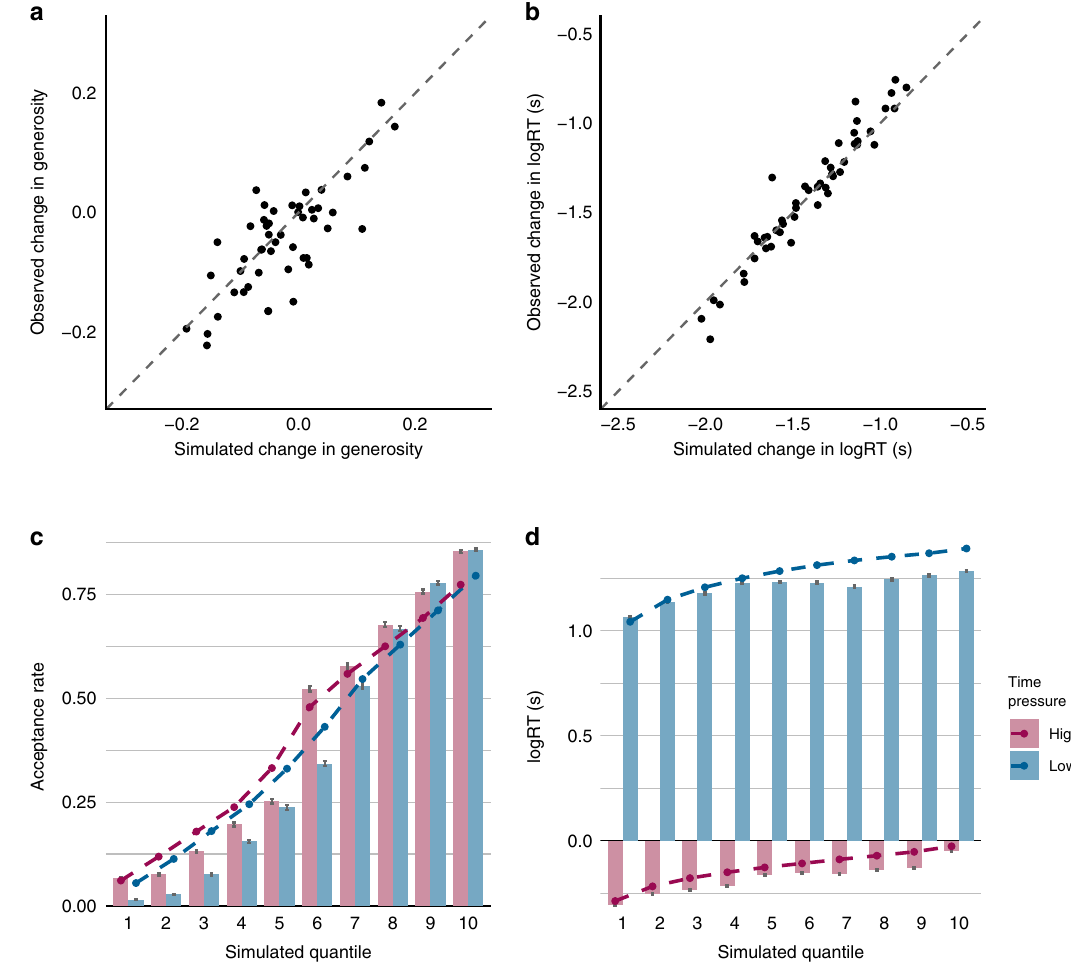
Fig. 5 Simulated vs. observed behaviour in the gaze-informed ADDM. Model versus observed inter-individual differences in a change in proportion generosity under time pressure, and b change in logRT under time pressure. Each point represents a subject ( N = 50), and points on the dashed line indicate perfect simulation of the observed data. Bottom panels illustrate simulated versus observed intra-individual differences, coloured by time pressure condition, in c acceptance of proposed offers, and d logRT, binned into ten model-predicted quantiles within individuals. Column height represents the observed group averages with error bars denoting one standard error above and below the mean. Points on the dashed line represent the simulated averages within these quantiles across individual subjects ( N = 50). Source data are provided as a Source Data fi